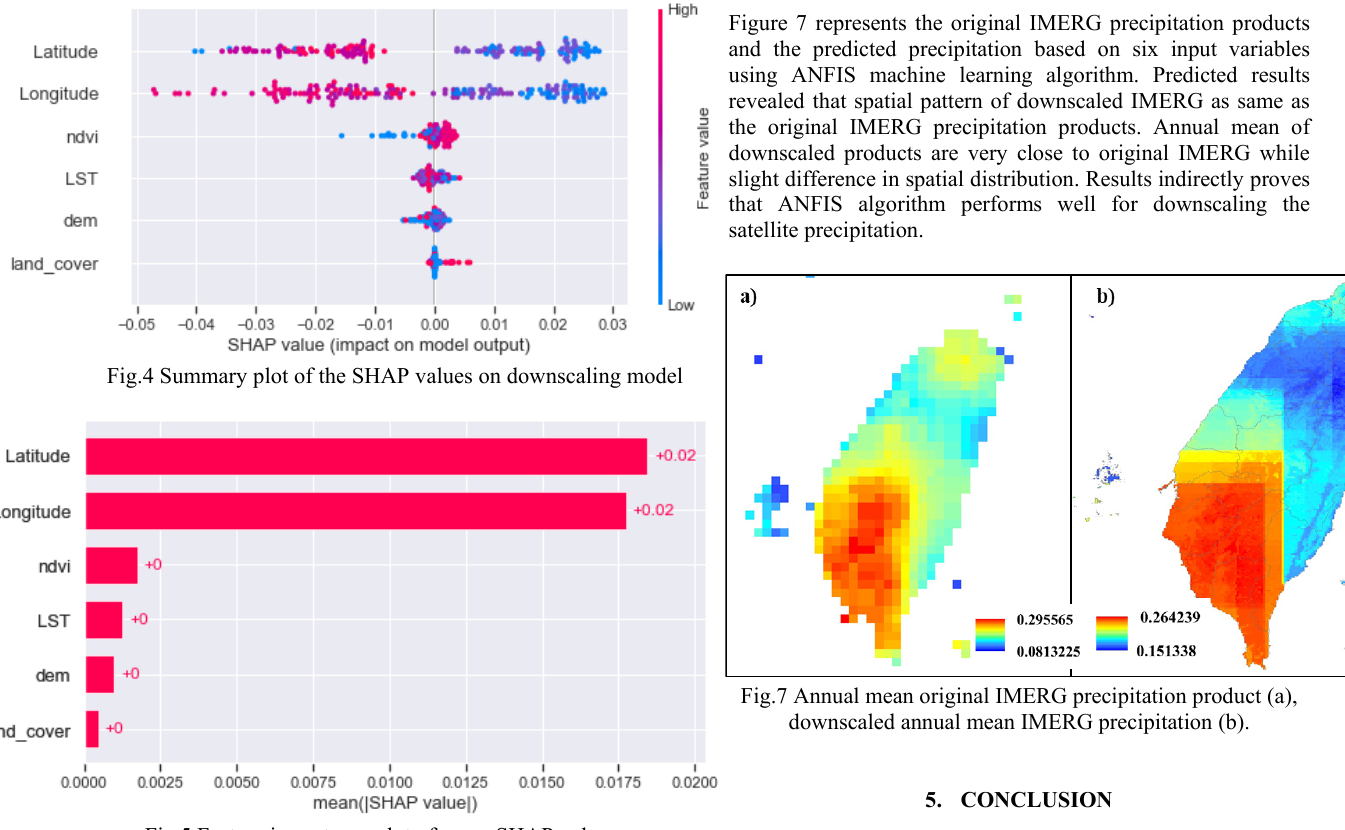
Fig.5 Feature importance plot of mean SHAP values on downscaling model